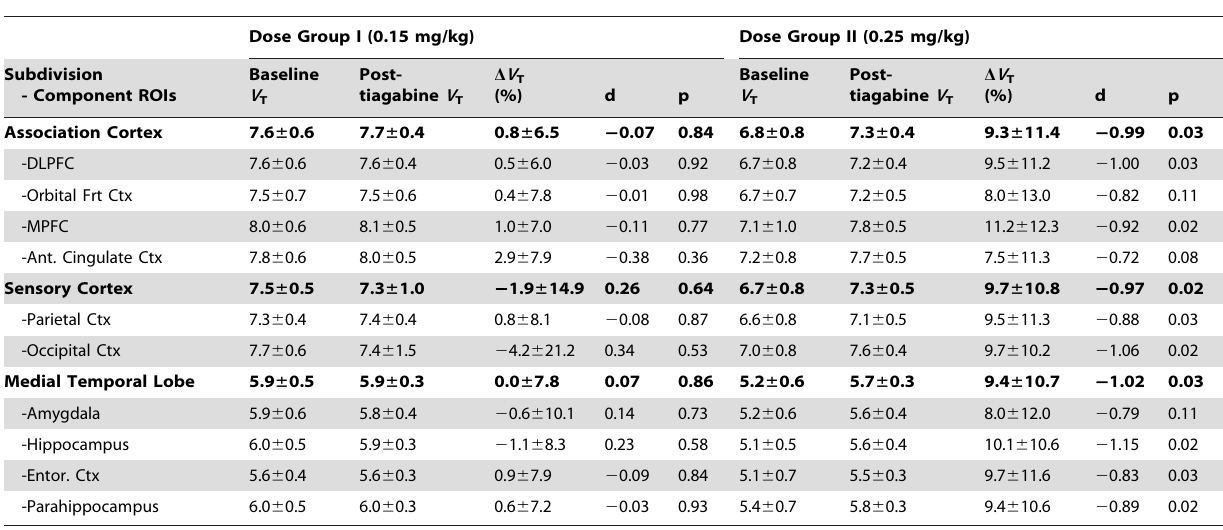
Table 2. Tiagabine-induced change in [11C]flumazenil V T in control subjects.